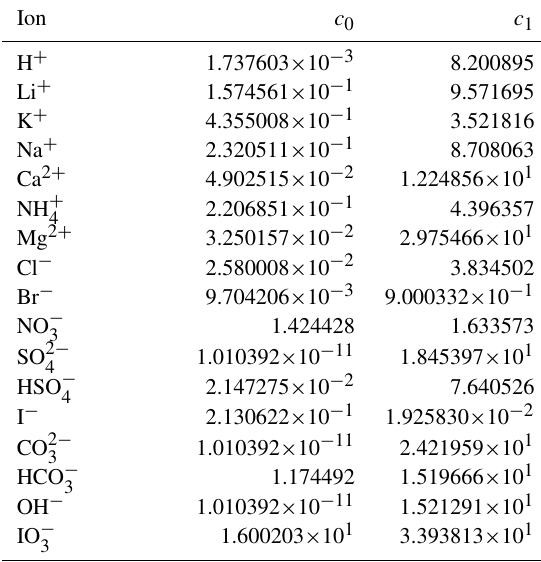
Table 6. AIOMFAC-VISC ion coefficients, c 0 ,i and c 1 ,i . a